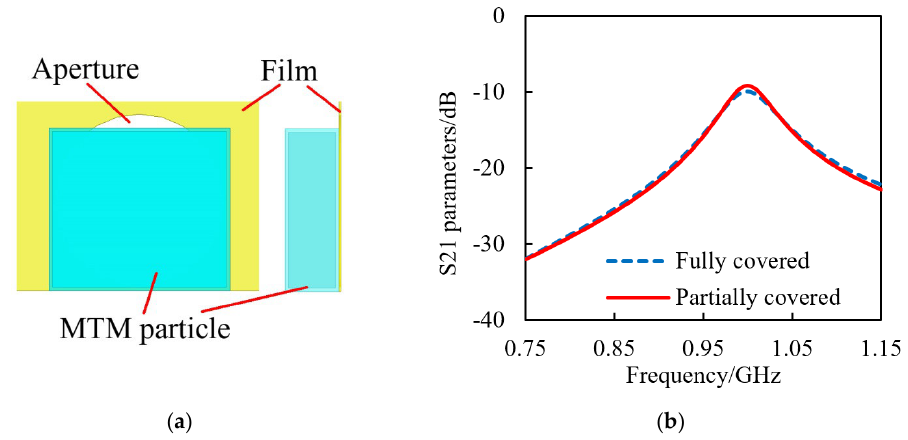
Figure 9. ( a ) The MTM particle partially covering the aperture and ( b ) the simulated S 21 parameters of the system with the MTM particle partially covering the aperture.